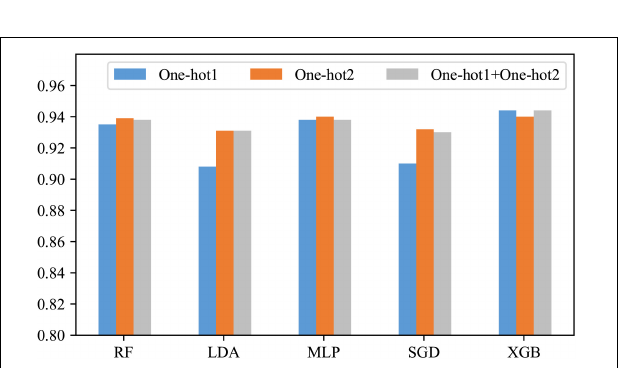
FIGURE 5 | Effects of the ensemble